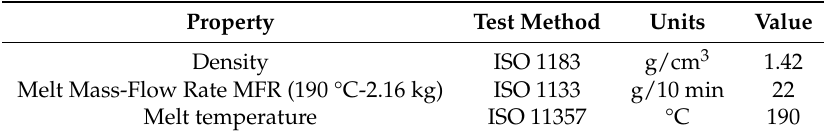
Table 2. Process parameters settings for the DOE plan.